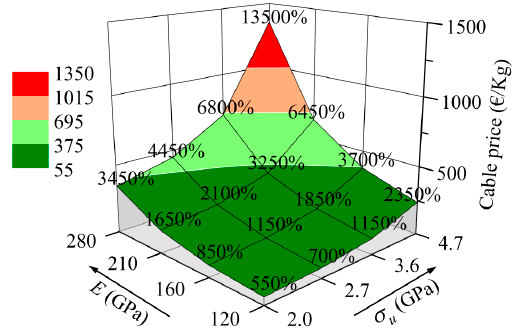
Figure 35. Estimate of unit prices of CFRP cables compared to that of steel cable.